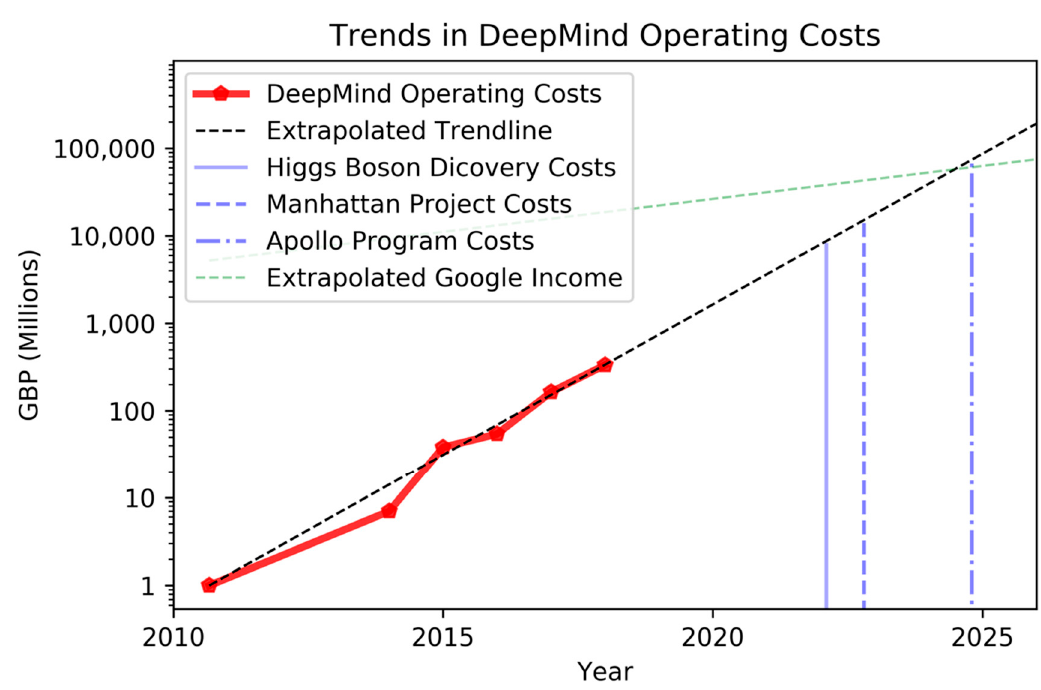
Figure 3. This depicts a simple extrapolative forecast of a social indicator. This is an example of